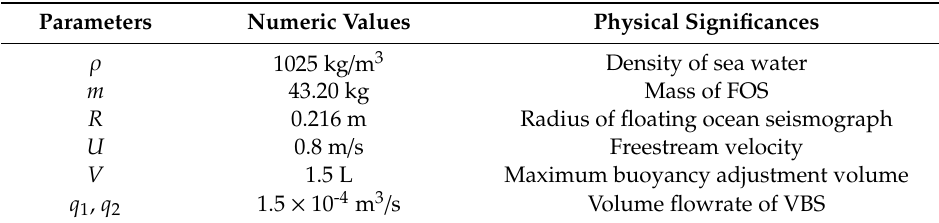
Table 3. The major parameters in the calculation.